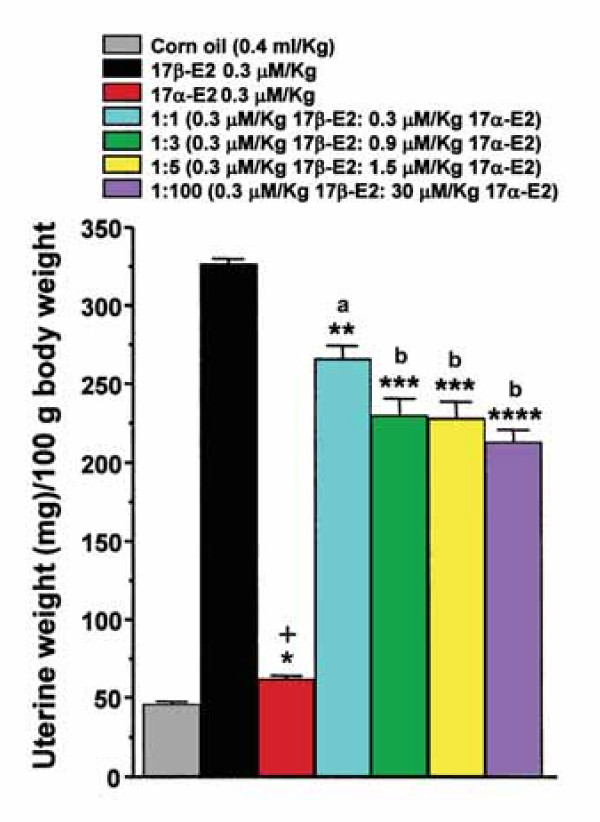
Action of 17α- and 17β-E2 on uterine mass in adult ovariectomized rats. 17α-E2 significantly increased the uterine weight as compared with the vehicle (corn oil; *P < 0.05), although this increment was significantly less than those of 17β-E2 (+P < 0.00005). In rats treated with 17β-E2 plus different doses of 17α-E2, less uterotrophic effect of 17β-E2 was evident. Statistical significance: **P < 0.005, ***P < 0.0005, ****P < 0.0001. The analysis shows that the treatment 1:1 (a) was different from 1:3, 1:5 and 1:100 (b; P < 0.05), which were not different between them (b; P > 0.05). Each bar represents the mean ± SEM, n = 6 rats per group.